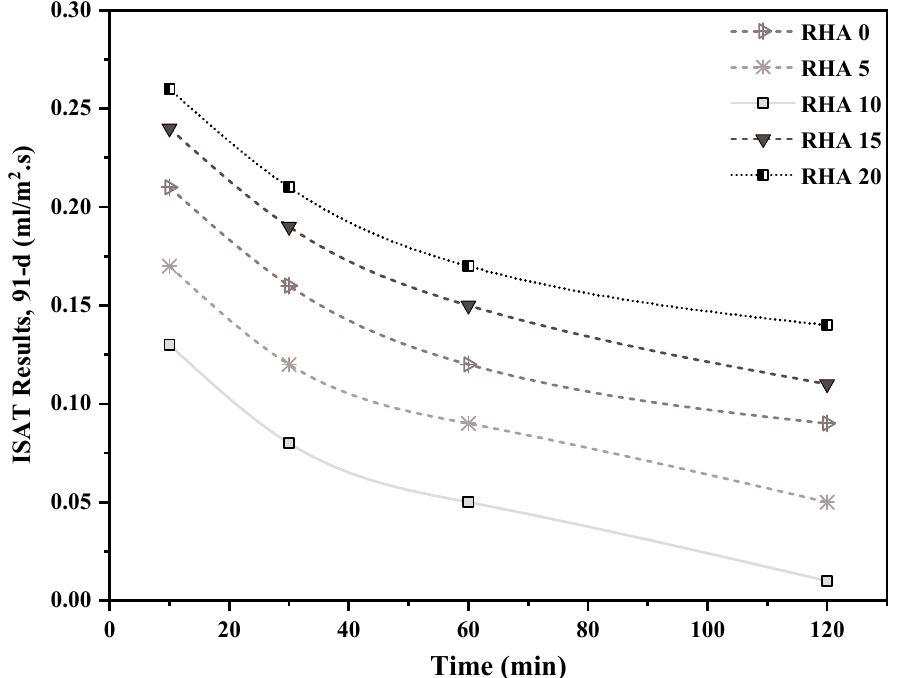
Figure 14. ISAT results, after 91 days, of concrete incorporating different percentages of RHA.